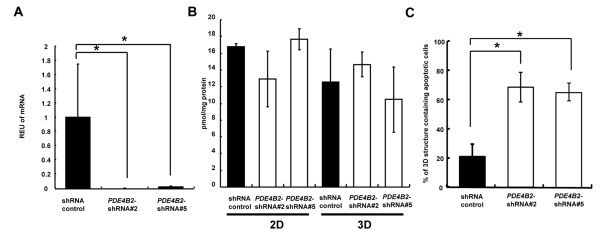
Induction of luminal apoptosis byPDE4B2-shRNAs in HCT116 cells grown in 3 DC.(A) mRNA expression levels for PDE4B2 in 3 DC. *, P < 0.005. (B) The amount of cytoplasmic cAMP in HCT 116 cells grown in 2-D or 3-D culture. (C) The ratio of the 3-D structures containing apoptotic cells. *, P < 0.005. mRNA expression levels for PDE4B2 in HCT116 cells with control shRNA (black bar) and PDE4B2-shRNAs (white bar) grown in 3 DC.